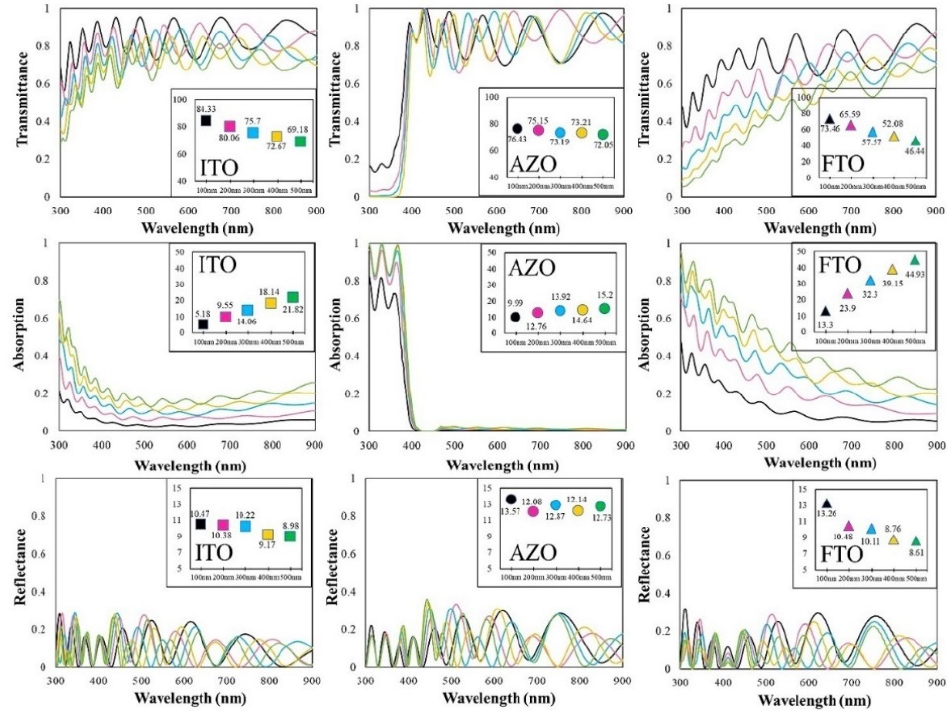
Figure 5. ART plots of indium tin oxide (ITO), fluorine tin oxide (FTO), aluminum zinc oxide (AZO) layers deposited on ultra-thin